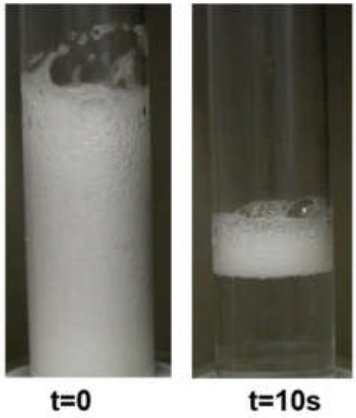
Figure 1. The foam evolution in the chitosan 100 ppm in the presence of 1%wt. acetic acid. Lauroyl ethyl arginate (LAE) is a cationic surfactant. Its 100-ppm solution lowers the surface tension to about 40 mN/m in the time about the 1500 s. The addition of acetic acid does not reduce the surface tension equilibrium values (cf. Figure S2). However, it significantly accelerates the kinetics of adsorption and enables the achievement of values close to equilibrium within the 500 s (Figures S1 and S2). The observed acceleration of the adsorption kinetics of LAE in the presence of acetic acid may be the result of the joint competitive adsorption of LAE cationic surfactant and acetic acid. However, it may also be the result of the action of acetic acid on the cationic surfactant, in which the acid acts as an excess of electrolyte, i.e., it is a source of ionic strength. As a result of this interaction, the double adsorption layer is compressed around the molecules of the ionic surfactant, increasing its surface activity [79,80]. Both processes could also occur simultaneously. It was possible to generate high foams in the 100 ppm LAE solution (both in the presence and absence of 1%wt. acetic acid). However, the developed foams were characterised by a short lifetime of a few dozen seconds. Figure S3 shows the most stable of the described foams obtained with LAE solution in the presence of acetic acid. A mixture containing all the above-described components, i.e., 100 ppm LAE, 100 ppm chitosan and 1% wt acetic acid, also didn’t show significantly better surface activity (Figures S1 and S2) or foamability (Figure S4) properties than its components. The equilib- rium surface tension was only a few percent smaller than in the case of the mixture of LAE with acetic acid. Similarly, the height of the foam portion was ca. 10–15% larger than in the case of the chitosan or LAE solutions. The stability of the foam was also only slightly higher. Although ca. 80% of the foam disappeared within ca. 3 min of its generation, the residue foam fraction was noticeable even after 30 min. This indicates that the ageing process of the foams was prolonged, but it was still a metastable wet foam.